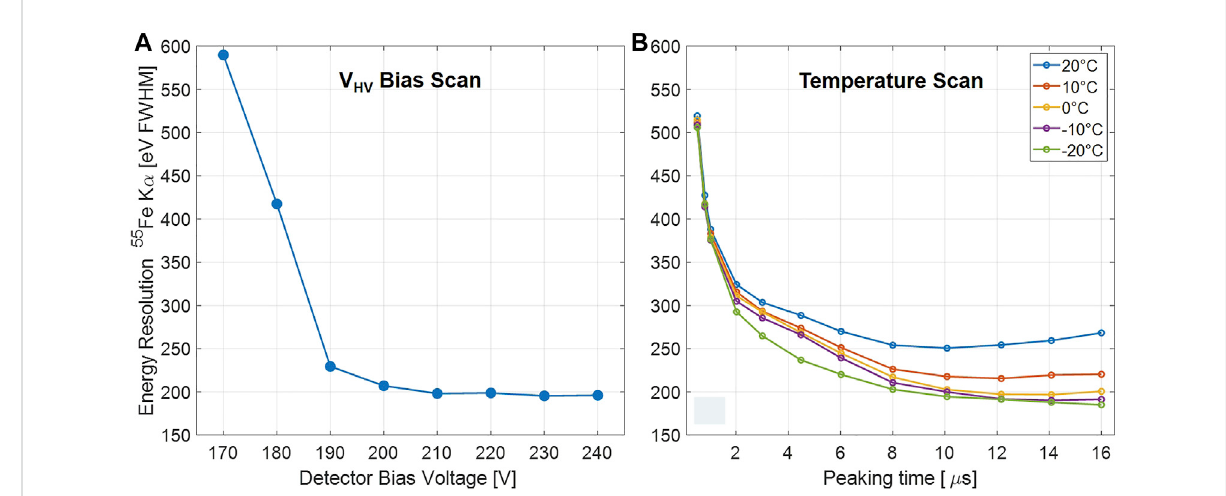
FIGURE 7 Premilinary optimization of the detector operating conditions: (A) strip bias voltage and (B)